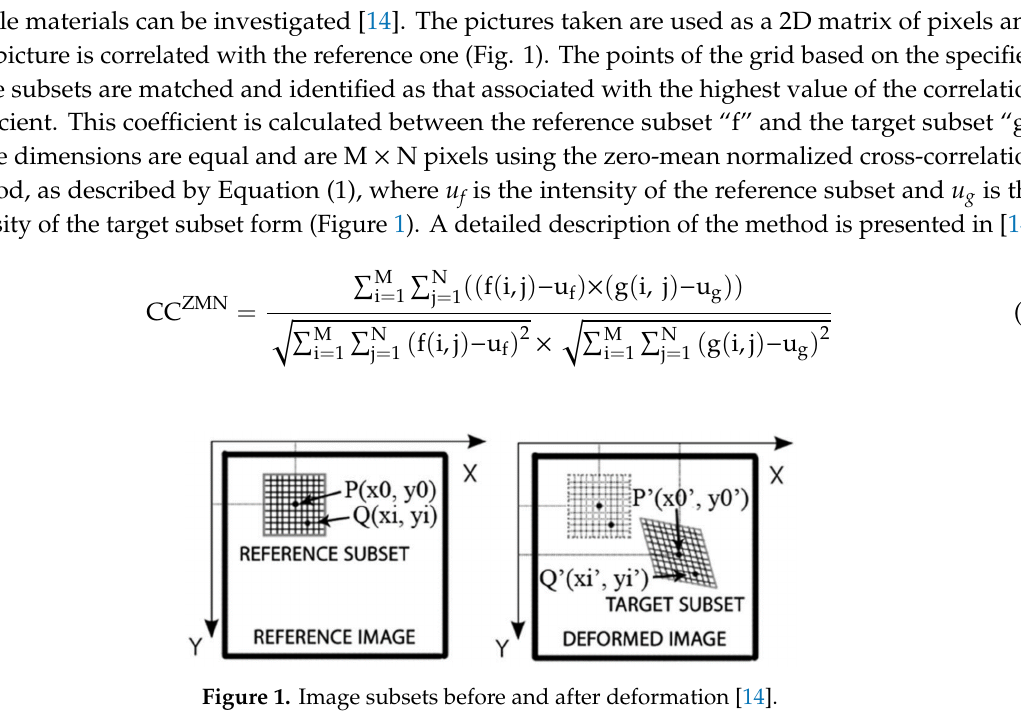
Table 1. Compositions of the tested